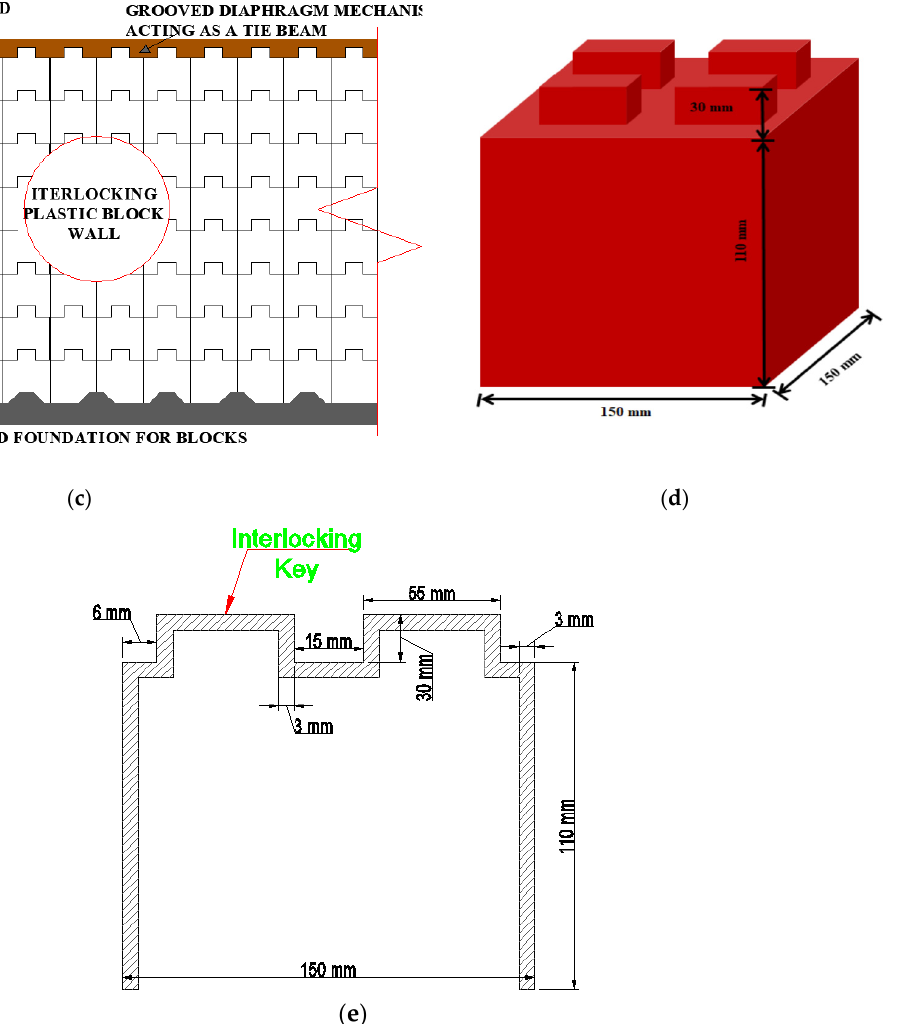
Figure 2. Proposed interlocking plastic block: ( a ) house plan, ( b ) 3D view, ( c ) wall assembly, ( d ) interlocking plastic block for real construction, and ( e ) cross-section of an interlocking plastic block.